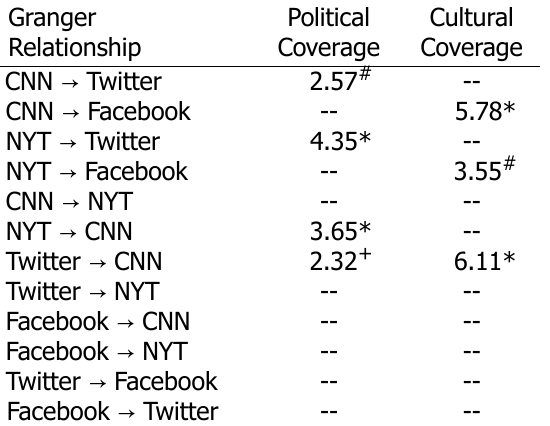
Table 3. Significant intermedia Granger-causal relationships in political and cultural coverage dis- tributions across